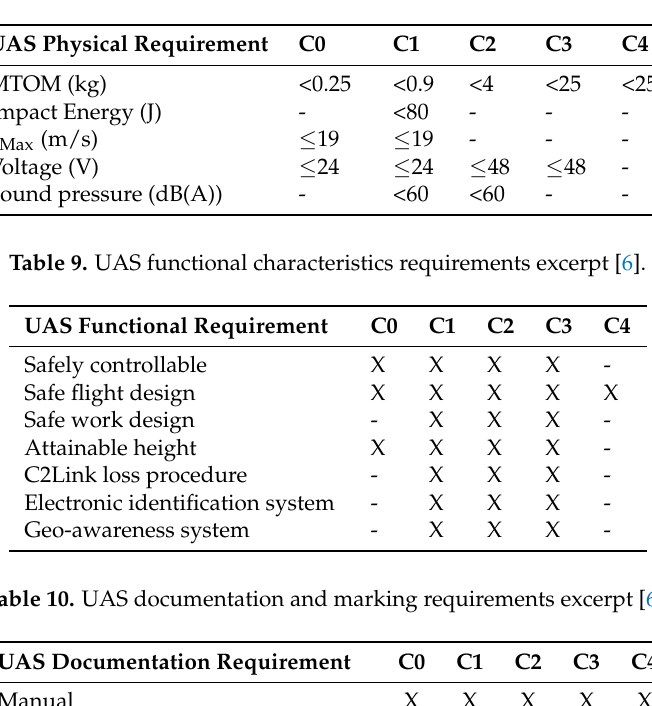
Table 8. UAS physical characteristics requirements excerpt [6].